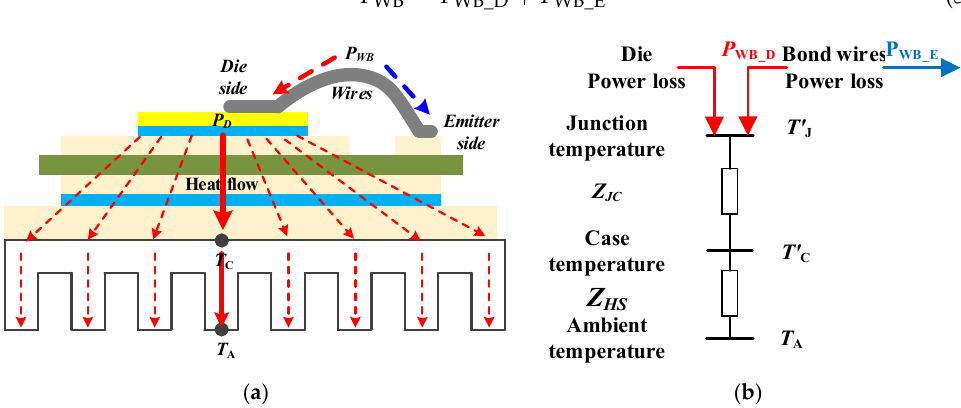
Figure 3. ( a ) Heat flow after bond wire lift ‐ off. ( b ) Thermal network of IGBT module after wire lift ‐ off.